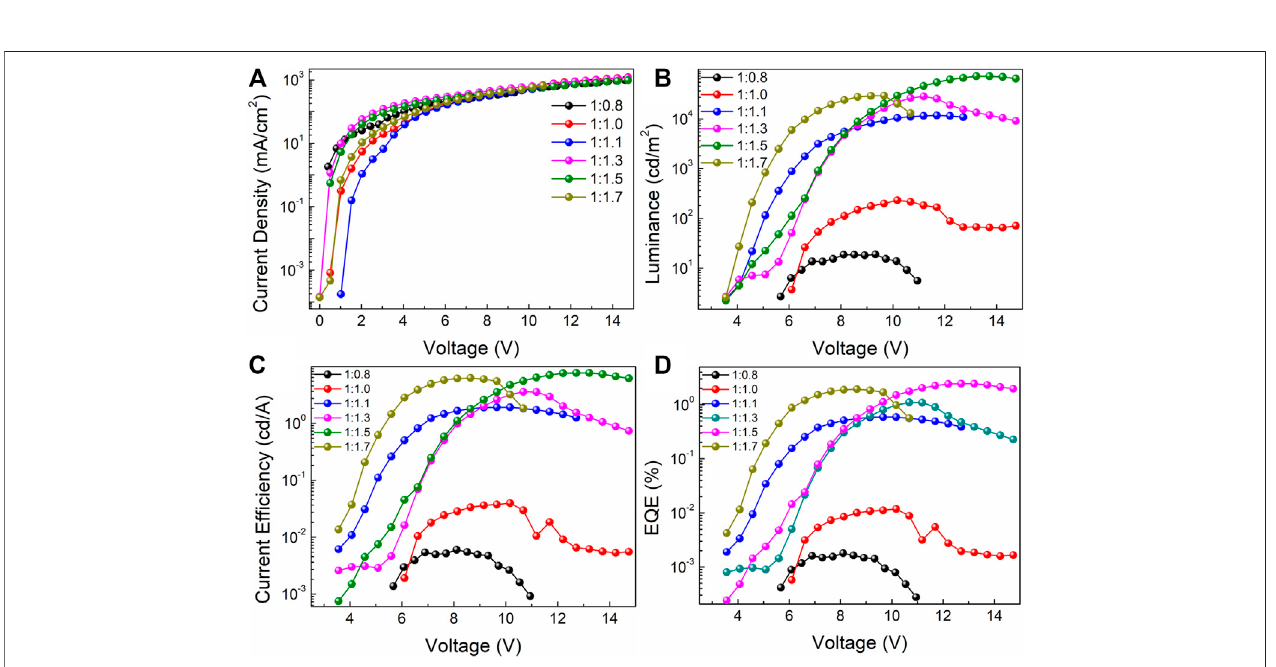
FIGURE 5 | (A) Current density-voltage ( J-V ), (B) luminance-voltage ( L-V ), (C) current ef fi ciency-voltage ( CE-V ), (D) EQE-voltage ( EQE-V ) of the PeLED devices based on the perovskite fi lms doped with different molar ratios of PbBr 2 and CsBr, such as 1:0.8, 1:1.0, 1:1.1, 1:1.3, 1:1.5, 1:1.7, respectively.